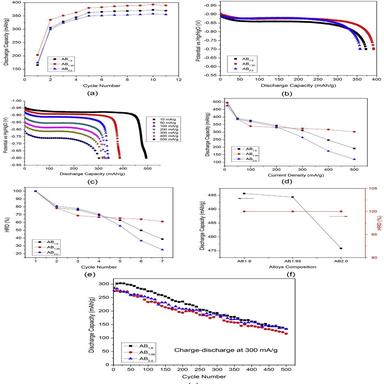
Gaseous capacity vs. electrochemical capacity for AB2.0 alloy. The inserts of the graphs show the tails of the curves measured from 0.85 to 0.6 V (cut-off voltage applied during the measurements of the discharge electrochemical capacity).